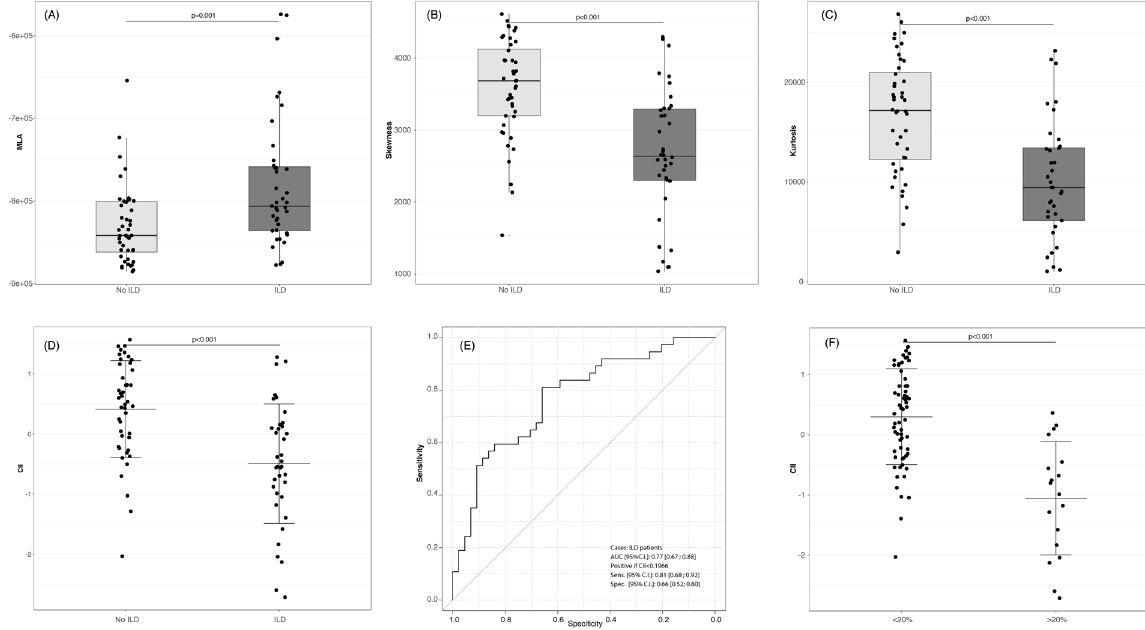
Figure 1. ( A – D ) Distribution of densitometric parameter values derived from the analysis of low-dose thin section volumetric lung CT in SSc patients without ILD in comparison with SSc-ILD cases. MLA, skewness and kurtosis are shown in panel (A–C), respectively. Distribution of CII values is shown in panel (D). The lower the value is for MLA and CII, the more severe the lung involvement is; on the contrary the higher the value is for skewness and kurtosis, the more severe the lung involvement is. ( E ) Diagnostic accuracy of CII by means of receiver-operating characteristic curve analysis. ( F ) CII in patients with limited ( < 20%) ILD in comparison with extended ILD ( > 20%), as assessed by the Goh visual score 10 . Lines represent mean ± standard deviation. CT = computed tomography; SSc = systemic sclerosis; ILD = interstitial lung disease; MLA = mean lung attenuation; CII = computerized integrated index; AUC = area under the curve; CI = confidence